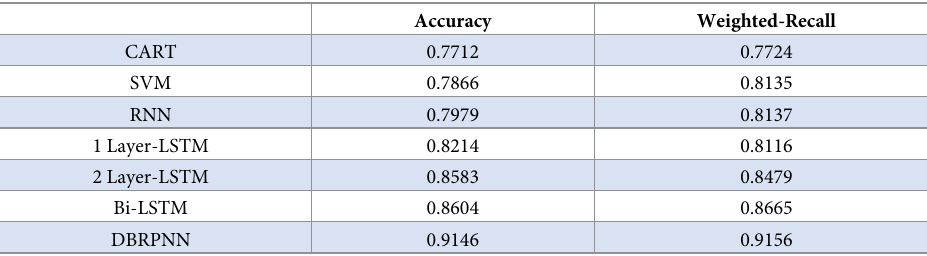
Table 6. Network performance comparison.